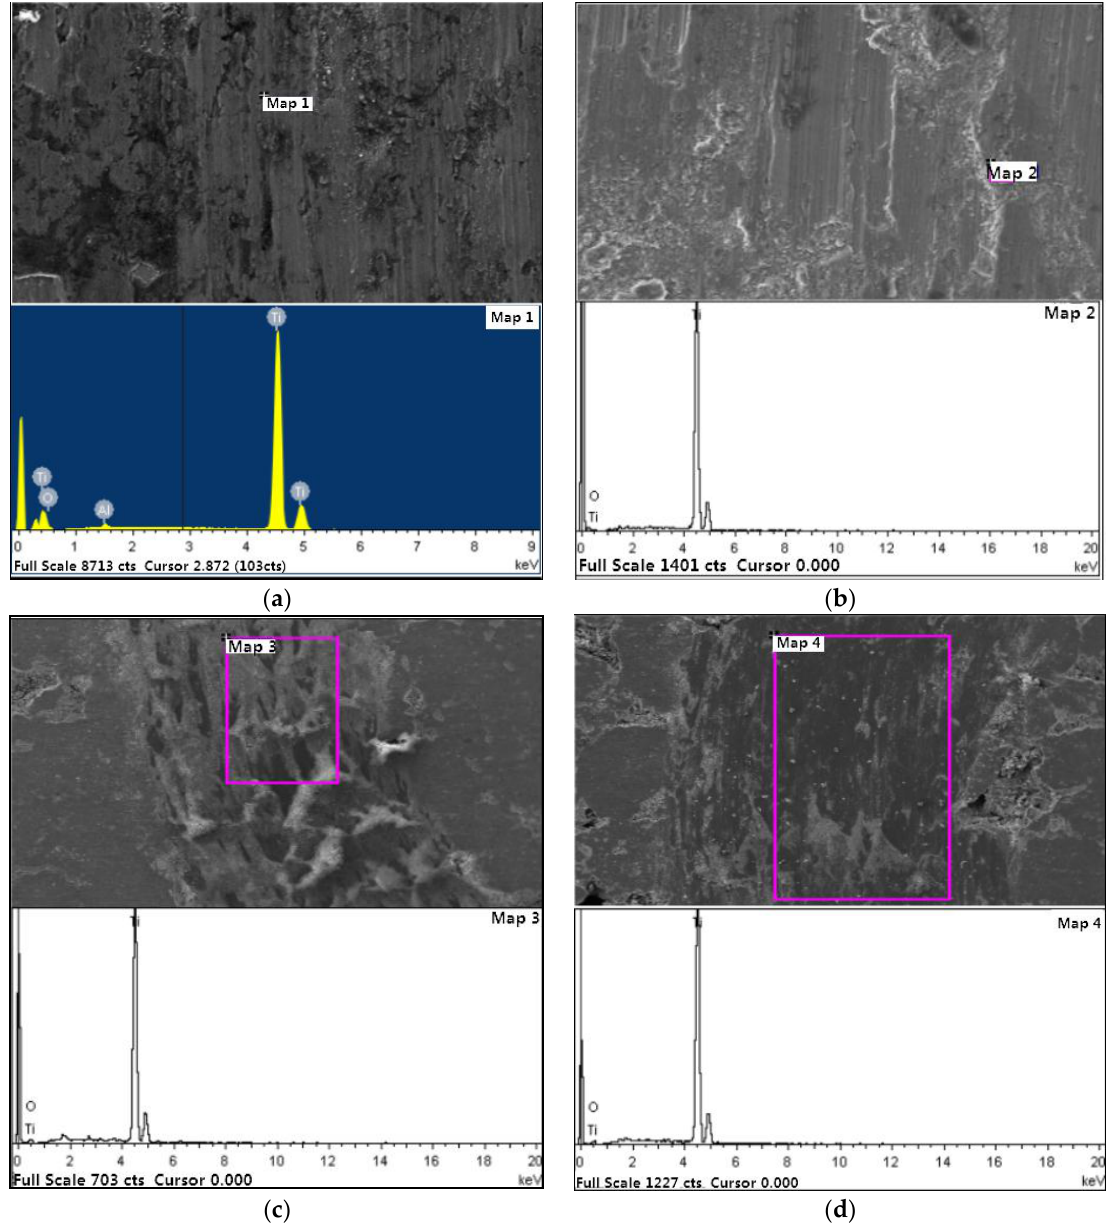
Figure 15. Wear surface analysis of porous titanium materials by EDS: ( a ) the porosity of the sample is ~24%–26%, the load is 10 N and the temperature is 20 °C; ( b ) the porosity of the sample is ~38%–42%, the load is 10 N and the temperature is 20 °C; ( c ) the porosity of the sample is ~38%–42%, the load is 6 N and the temperature is 200 °C; and ( d ) the porosity of the sample is ~38%–42%, the load is 6 N and the temperature is 300 °C.